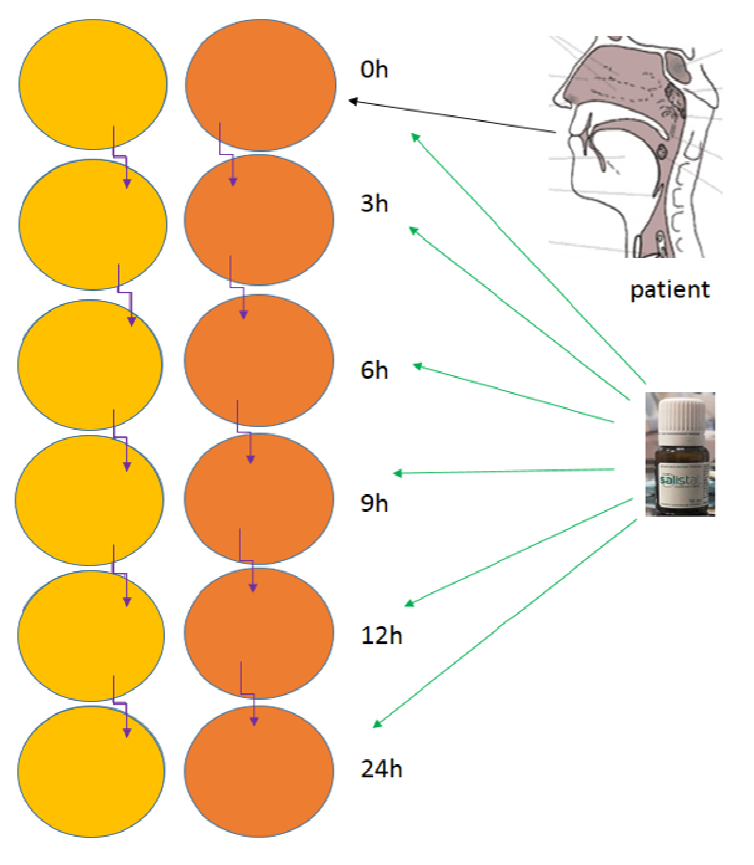
Figure 2. Schematic presentation on experiments part 2.